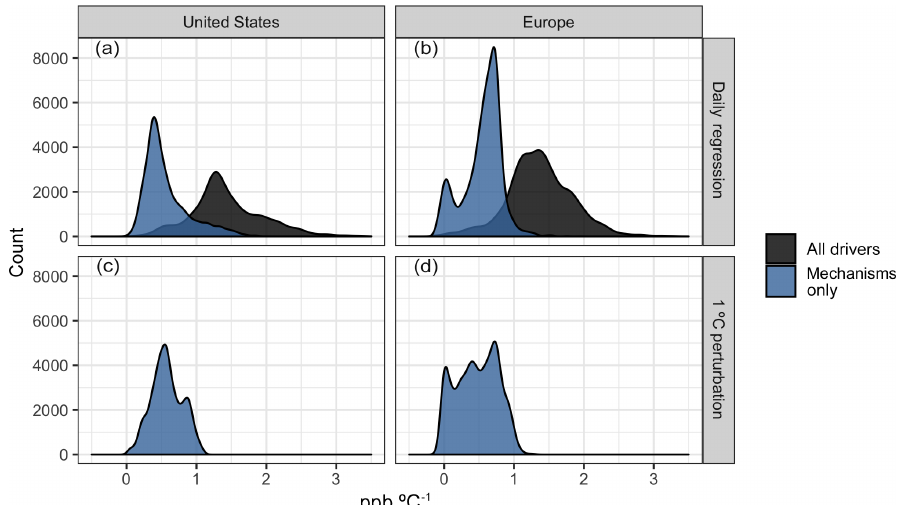
Figure 9. Distribution of O 3 – T sensitivities as measured by the slope of OLS regression (above) and mean surface O 3 differences from a flat 1 ◦ C temperature perturbation (below). Regression values are shown for all modeled drivers (BASE case, black) and the portion of those slopes attributable to temperature-dependent mechanisms (BASE − ALL, blue).